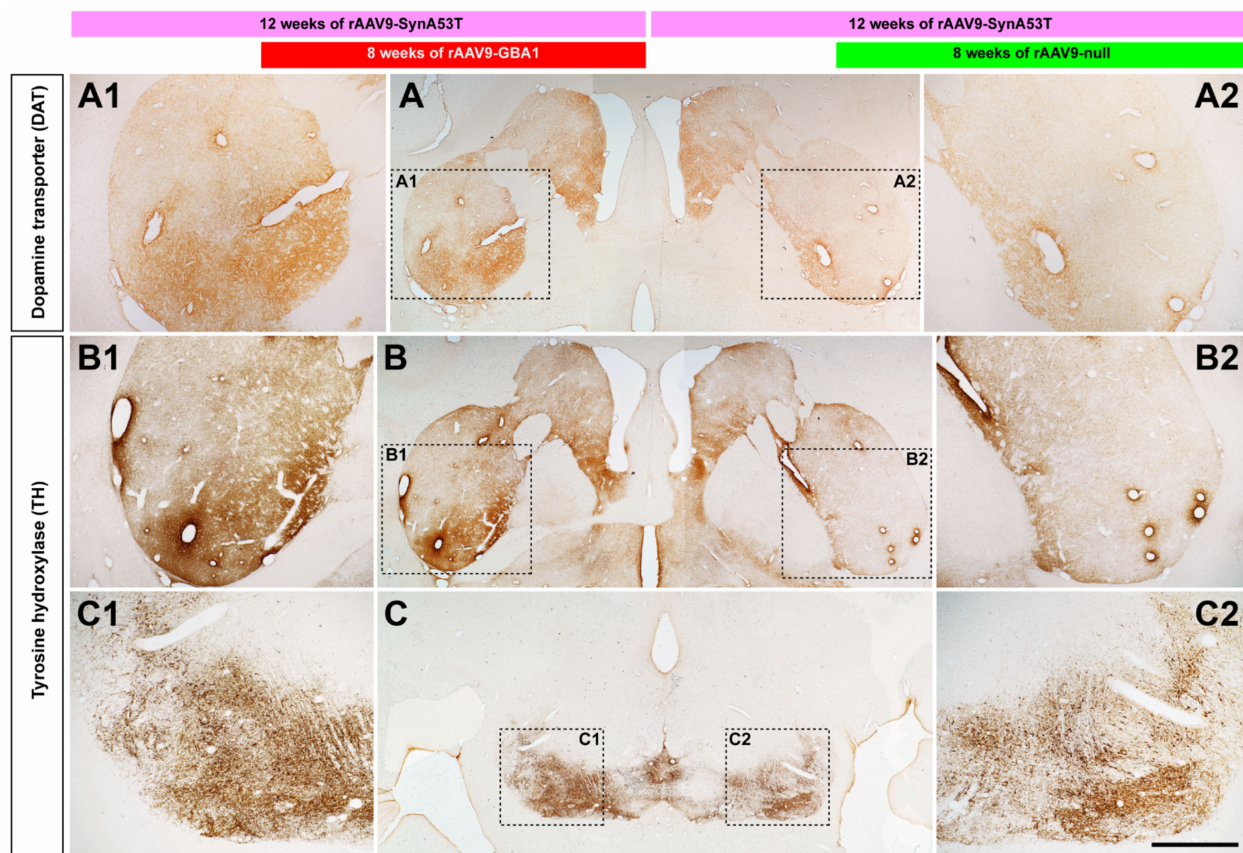
Figure 6. Immunohistochemical detection of dopaminergic markers in NHPs. Panels A and B are coronal sections taken at the level of the post-commissural caudate and putamen nuclei showing the staining pattern for the dopaminergic transporter (DAT) and TH. Panels A , A1 and A2 show a higher staining intensity obtained for DAT in the left striatum (e.g., the one innervated by the left SNpc where rAAV9-GBA1 was delivered) when compared to the right striatum (e.g., the one located ipsilateral to the right SNpc, injected with the control vector). Panels B , B1 and B2 were taken from an adjacent section and showed that the TH staining patterns were very similar to the ones of DAT. Panels C , C1 and C2 were taken at the level of the SNpc and illustrate the left vs. right differences in TH-immunoreactive profiles. Even at low magnification, it can easily be observed that the treatment with rAAV9-GBA1 (left SNpc, C1 inset) resulted in better preservation of the number of TH+ neurons when compared to the right SNpc (the latter treated with the control vector; C2 inset). Scale bar is 4000 µ m for low-magnification images and 2000 µ m for